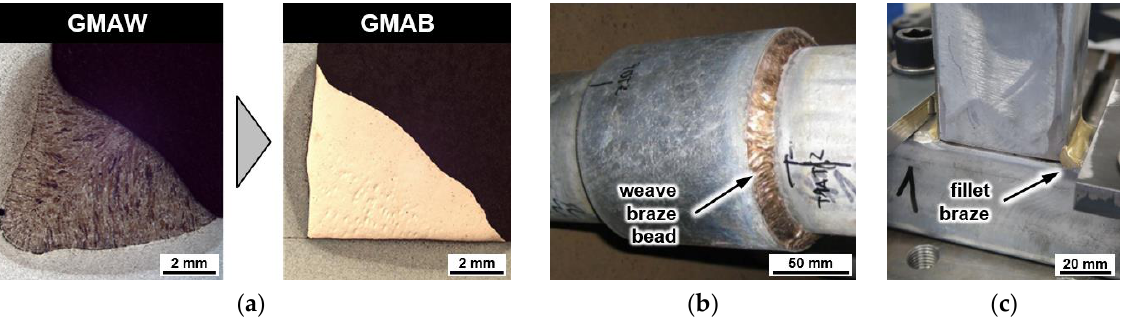
Figure 1. Application of arc brazing: ( a ) comparison of fillet welded and fillet brazed joint; ( b ) arc brazed grey water pipe socket in ship building; ( c ) arc brazed hollow section T-joint in steel construction. (© Fraunhofer IGP).